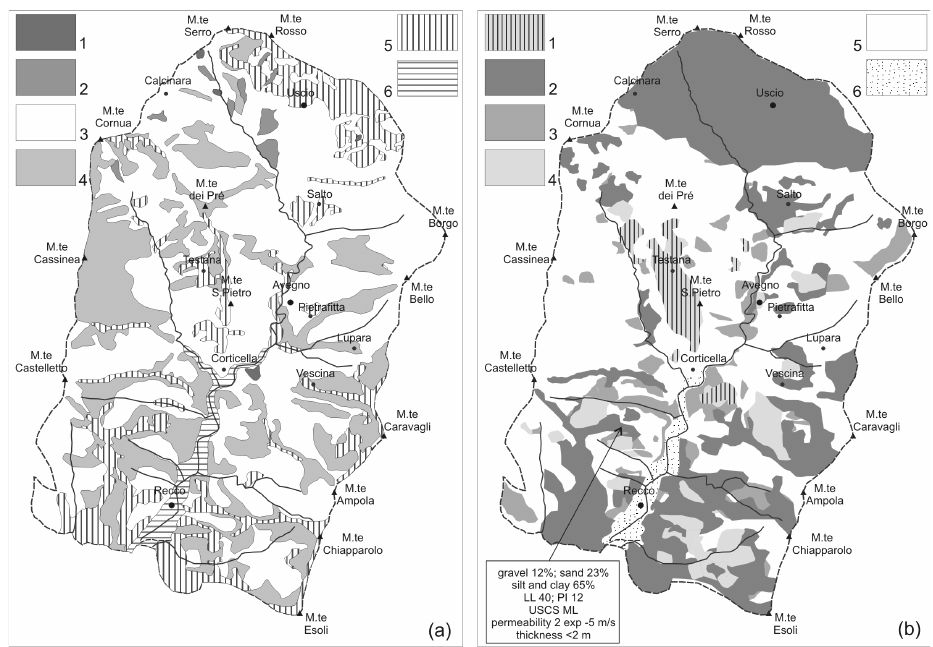
Fig. 7. (a) Geohazard map (modified from Recco Stream catchment Master Plan): 1. very high, 2. high (only dormant landslides), 3. high, 4. medium, 5. low, 6. very low. (b) Example of GIS-based model map for susceptibility of slopes to rainfall-triggered instability: 1. thin debris cover on unfavourable bed attitude, 2. thin debris covers, 3. thick debris covers, 4. palaeolandslides, 5. outcropping bedrock, 6. alluvial deposits.